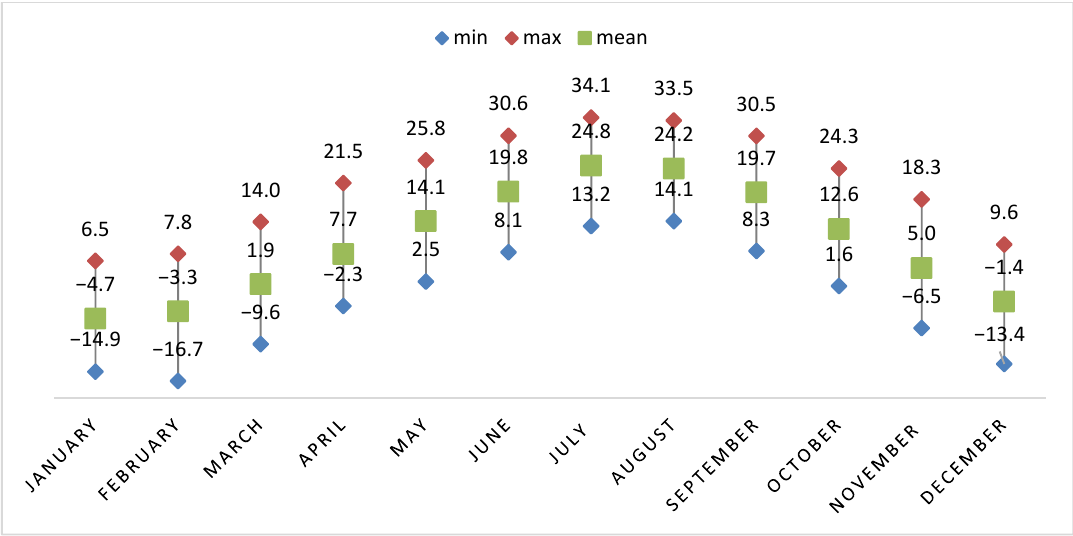
Figure 3. Mean, minimum, and maximum monthly temperatures for Istanbul .